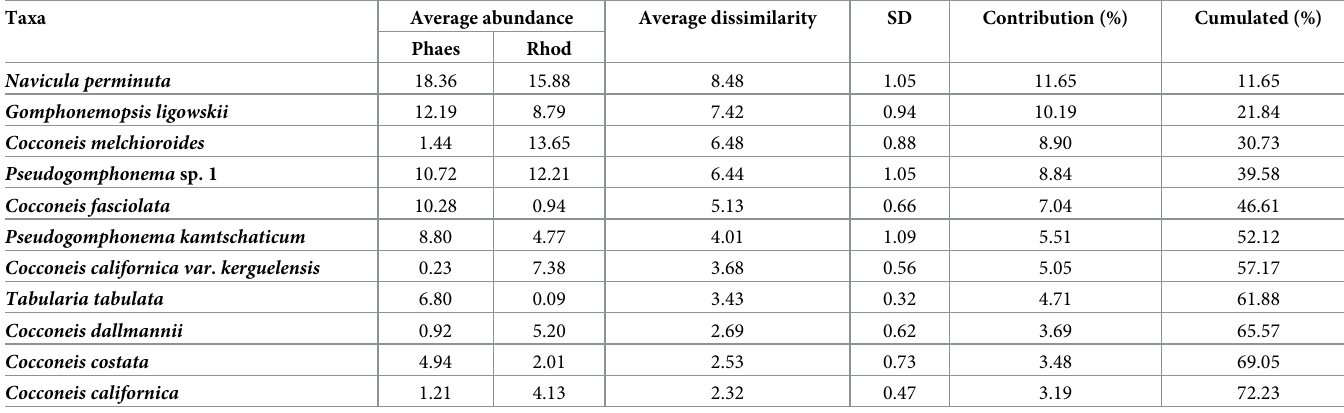
Table 4. Average abundance and dissimilarity of diatom communities from Rhodophyta (Rhod) and Phaeophyceae (Phae).